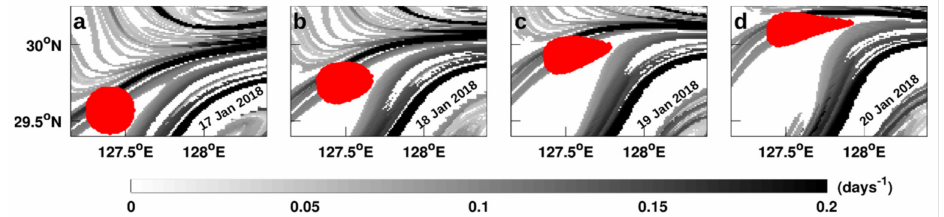
Figure 5. A moving Lagrangian front simultaneously transporting a nearby numerical tracer. Panels ( a – d ) are daily finite-size Lyapunov exponent maps from the 17th to 20th of January 2018. The sharpest Lagrangian front attracts the red numerical tracer and at the same time displaces the tracer northward while drifting in this direction. The drift of the front occurs during the stretching of the passive tracer. Without considering the drift of the front, the predicted position of the tracer would be expected several tens of km south of its real